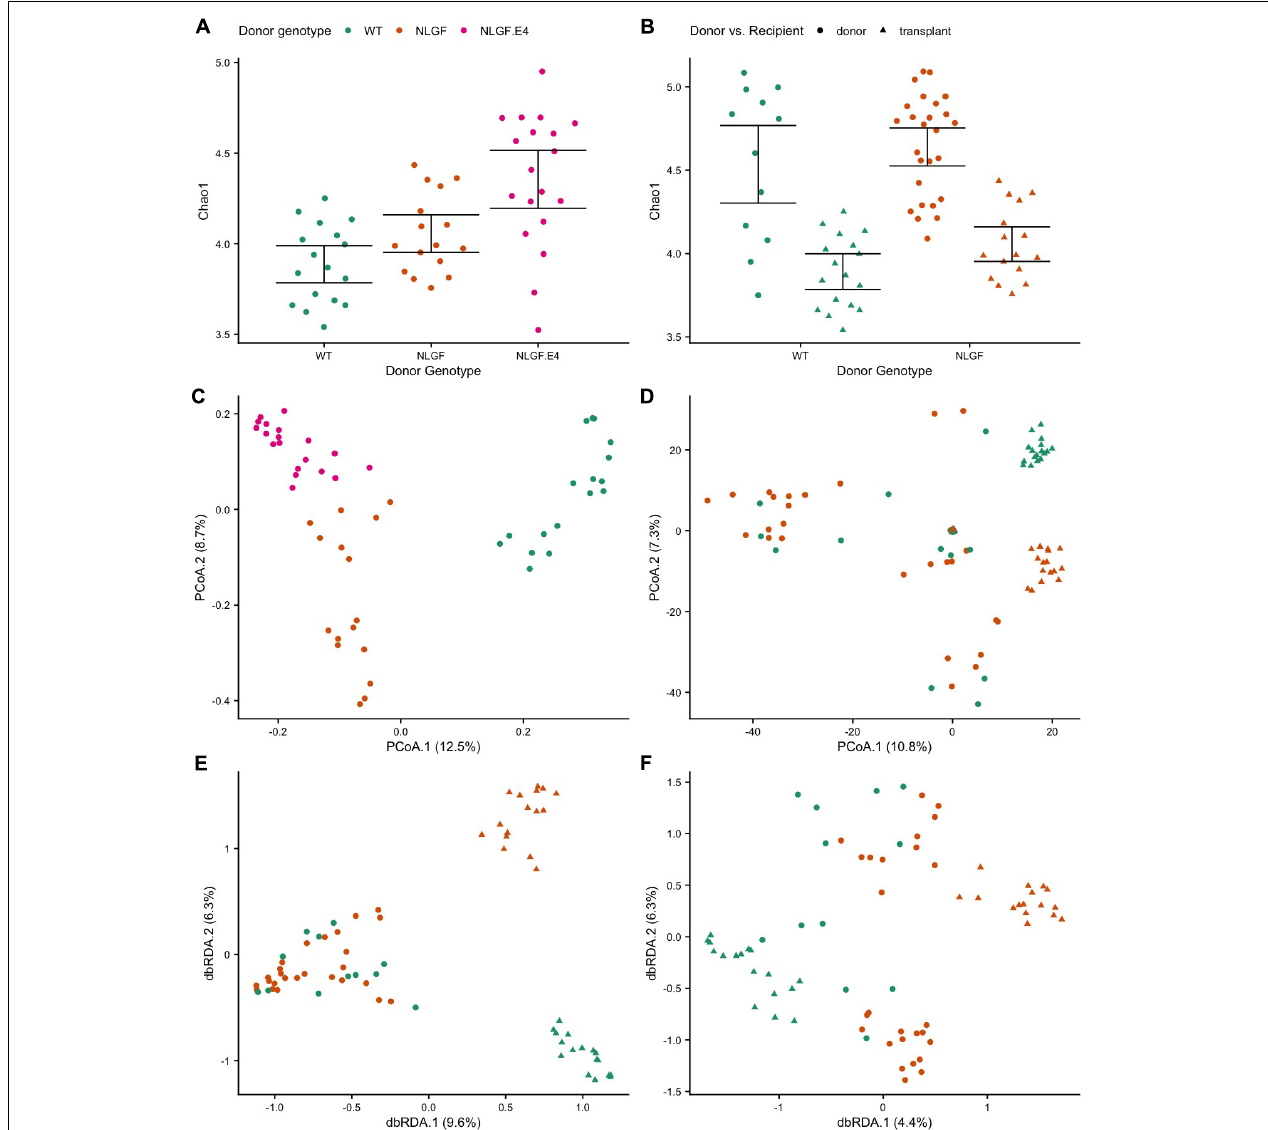
FIGURE 6 | Alpha- and beta-diversity scores by donor genotype and/or transplant status. (A) Chao1 index scores by donor genotype for recipients of microbiome transplants showing increased diversity for microbiomes transplanted from App NL − G − F / E4 mice donors compared to transplants from WT donors. (B) Chao1 index scores by donor genotype and donor vs recipient samples showing decreased diversity in transplanted microbiomes compared to donor microbiomes, regardless of genotype. (C) Principal Coordinate Analysis (PCoA) ordination of differences in microbiome sample composition according to Canberra distances by donor genotype for recipient samples showing that transplanted microbiomes cluster by donor genotype. (D) PCoA ordination of Canberra distances by donor genotype and donor vs recipient samples showing that microbiomes cluster by transplant status (donor or recipient) and donor genotype. (E) Distance-based Redundancy Analysis (dbRDA) ordination of Canberra distances constrained to maximize variance by donor genotype and donor vs recipient status, which highlights the small differences in composition between donor microbiome genotypes, but much larger differences between microbiome of donor genotypes in the recipient mice. (F) dbRDA ordination of Canberra distances constrained by donor genotype after accounting for variance explained by donor vs. recipient status, which highlights the significant effects of donor genotype on the recipient microbiome composition even after accounting for the effects of transplantation.